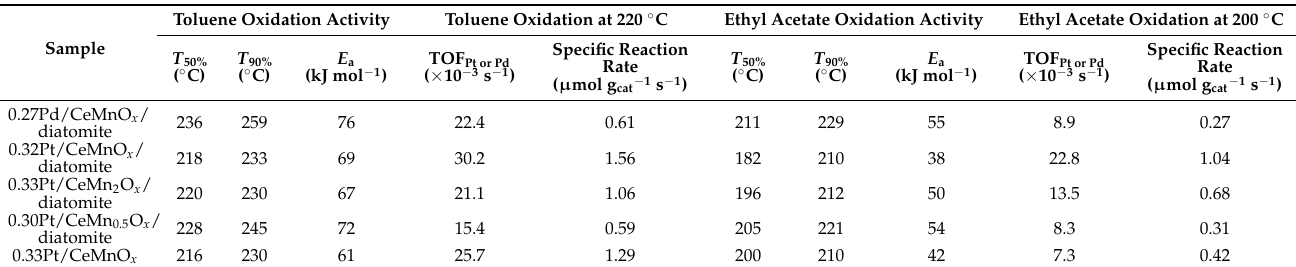
Catalytic activities of the samples for ethyl acetate and toluene oxidation at SV = 20,000 mL g − 1 h − 1